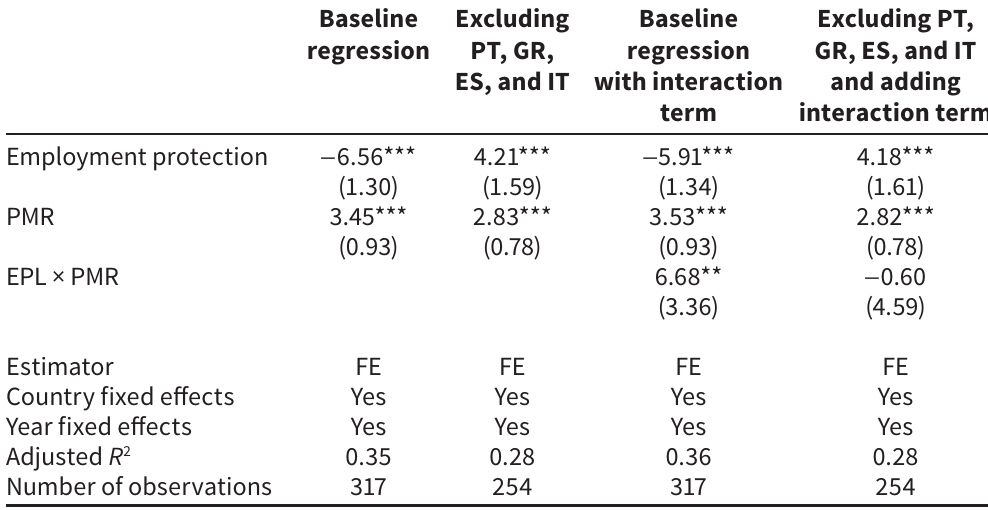
Robustness checks of the impact of EPL and PMR on the unemployment